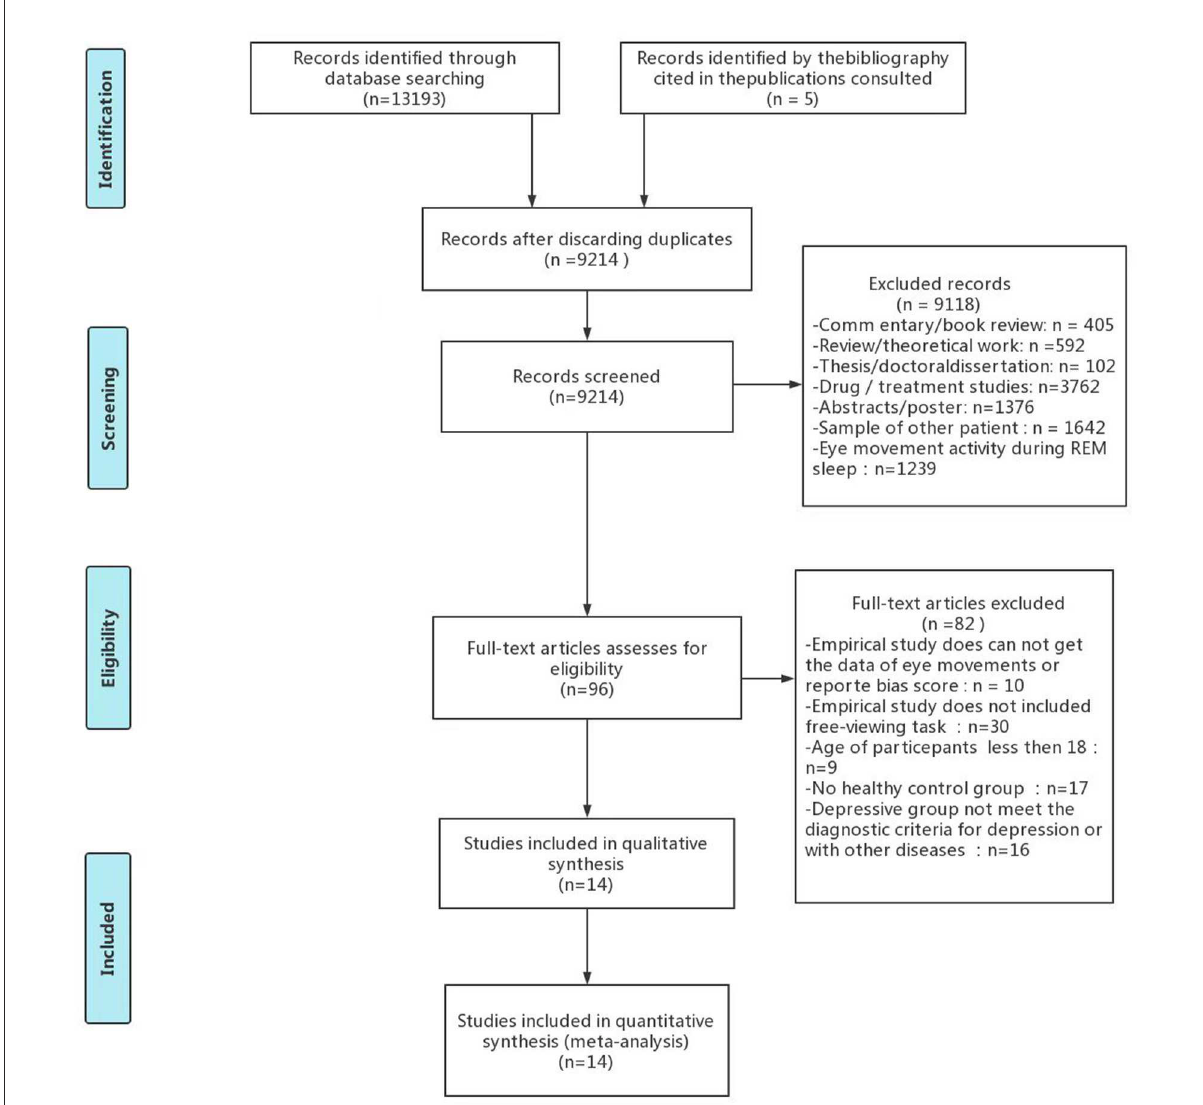
FIGURE1 Flow diagram of the excluded and included